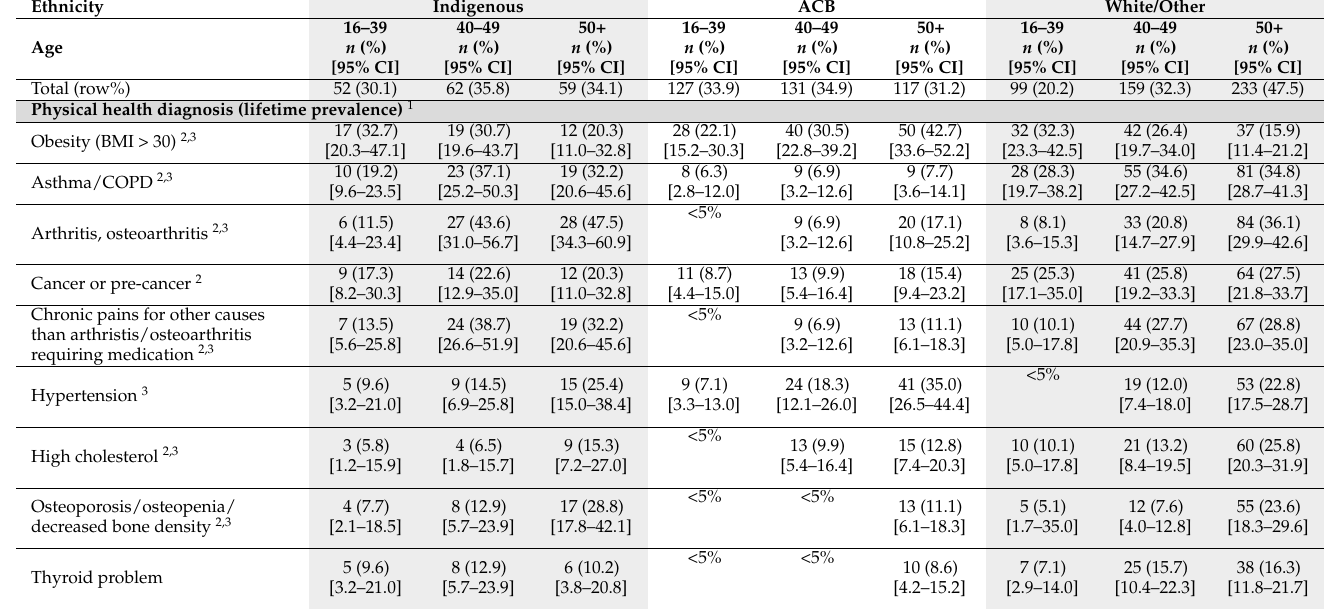
Table 3. Prevalence of comorbidities in participants from the Canadian HIV Women’s Sexual and Reproductive Health Cohort Study (CHIWOS), stratified by age and